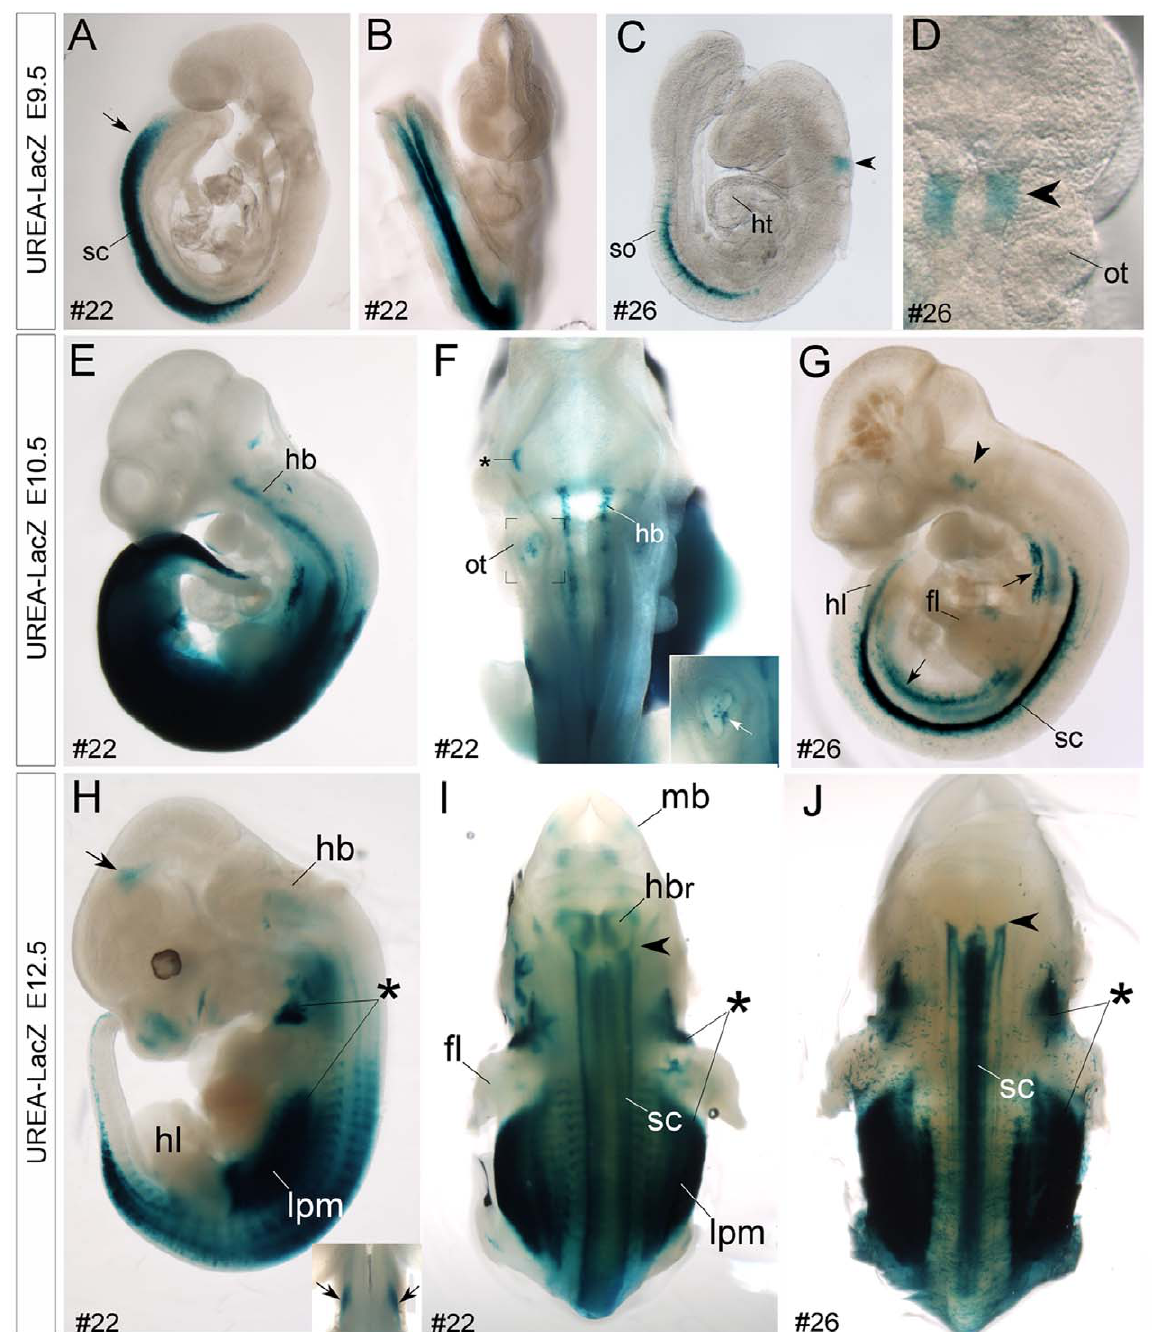
Figure 2. Detection of X-gal-positive signals in spinal cord and hindbrain of E9.5-E12.5 UERA–LacZ embryos. A–J: Whole mount X-gal staining of E9.5 (A–D), E10.5 (E–G) and E12.5 (H–J) UREA-LacZ embryos. Prominent X-gal-positive signals are detected in the spinal cord (sc) of either line # 22 (A, B, E, F) or # 26 (C, D, G) UREA-LacZ embryos at E9.5 and E10.5. Note that, this expression is earlier and stronger in line # 22 than in line # 26. Interestingly, in the hindbrain (hb) region, X-gal-positive signals are detected in a selective domain of hindbrain (arrowhead) in line # 26 embryos at E9.5 (C, D) and E10.5 (G). Later at E12.5, the X-gal-positive signals expend into more caudal regions of hindbrain with a pattern of longitudinal columns (arrowhead in J indicates the anterior expression border). In line # 22 hindbrain, longitudinal X-gal-positive signals are detected from E10.5 at more broad regions than line # 26 (E, F). H, I: By E12.5, the X-gal-positive signals are also detected in the rostral part of hindbrain (hbr, H). Asterisks in H-J indicate strong X-gal-positive signals in the paraxial mesenchyme of embryos in both lines. Notably, X-gal-positive signals are also present in the lateral plate mesoderm (lpm, H, I; arrows in G) in both lines, and in otic vesicle (ot, F and white arrow in inset at high magnification) and midbrain region (mb, I; arrows in H and inset of H) of line # 22 embryos. Asterisk in F indicates a non-specific signal. fl, forelimb bud; ht, heart; hl, hindlimb bud; so, somites.